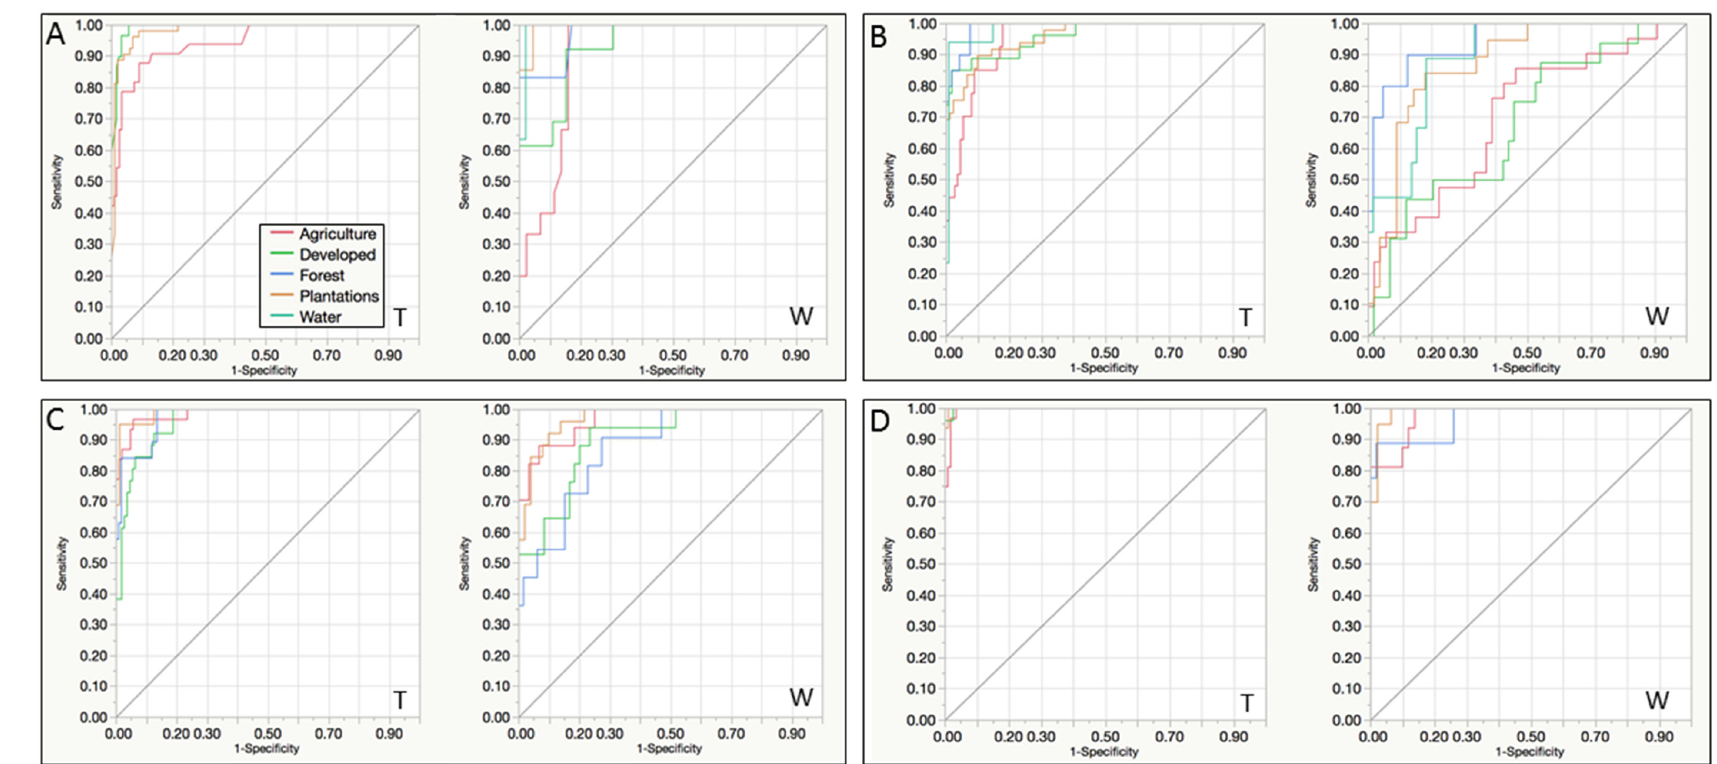
Figure 7. ROC training (T) and withheld (W) curves shown for Taninathryi, Myanmar for classifying agriculture, developed, forest, plantation, and water using ( A ) Landsat 8 OLI; ( B ) PALSAR-2; ( C ) Sentinel-1; and ( D ) fused/combined imagery.